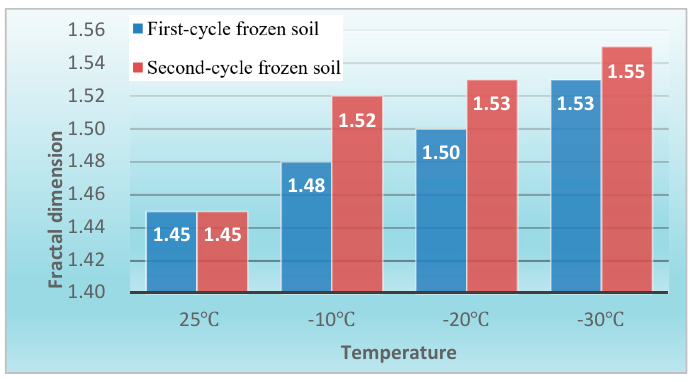
Figure 16. Average fractal dimension of soil pores.